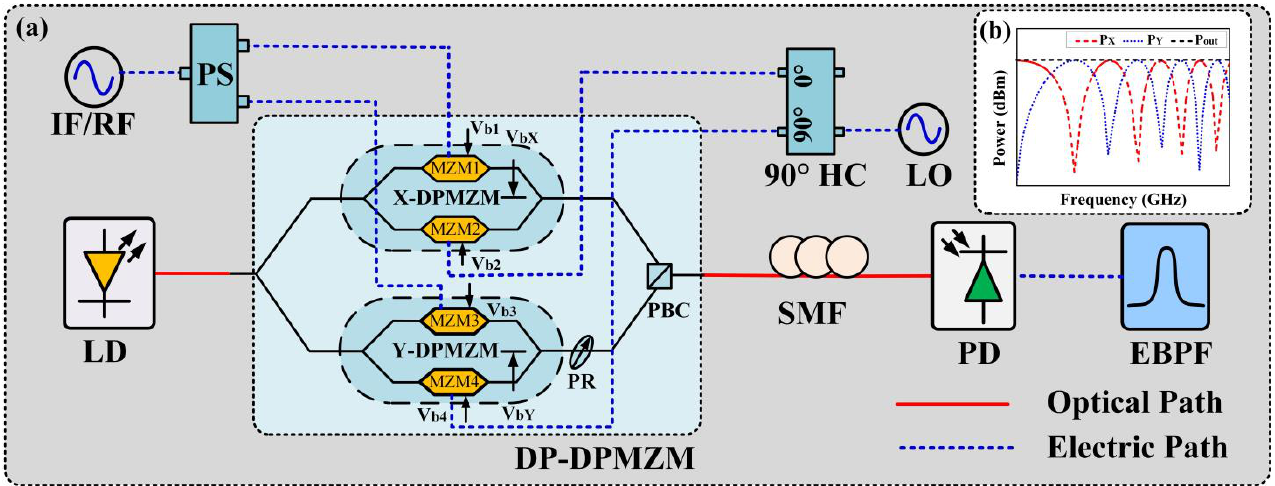
Figure 1. Schematic diagram of the proposed broadband microwave photonic mixer. ( a ) System architecture. ( b ) Frequency response of the fiber link based on the two orthogonally polarized optical signals. LD, laser diode; DP-DPMZM, dual-polarization dual-parallel Mach–Zehnder modulator; PR, polarization rotator; PBC, polarization beam combiner; PS, power splitter; LO, local oscillator; HC, hybrid coupler; SMF, single-mode fiber; PD, photodetector; EBPF, electrical bandpass filter; IF, intermediate-frequency; RF, radiofrequency.